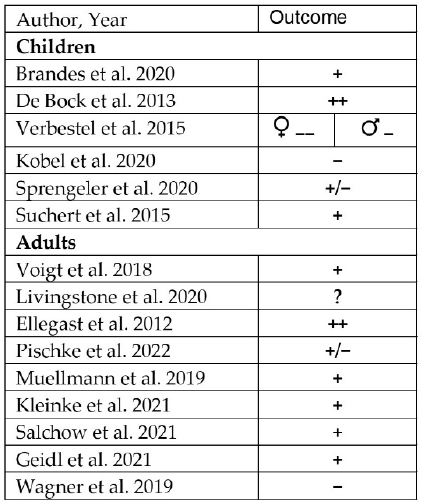
Figure 2. Summary of results of studies included in systematic review [69–78,85–89]. ++ significant reduction, −− significant increase, + tendency towards reduction in sedentary time, − tendency towards increase in sedentary time, ? significance cannot be assessed, +/ − mixed results.